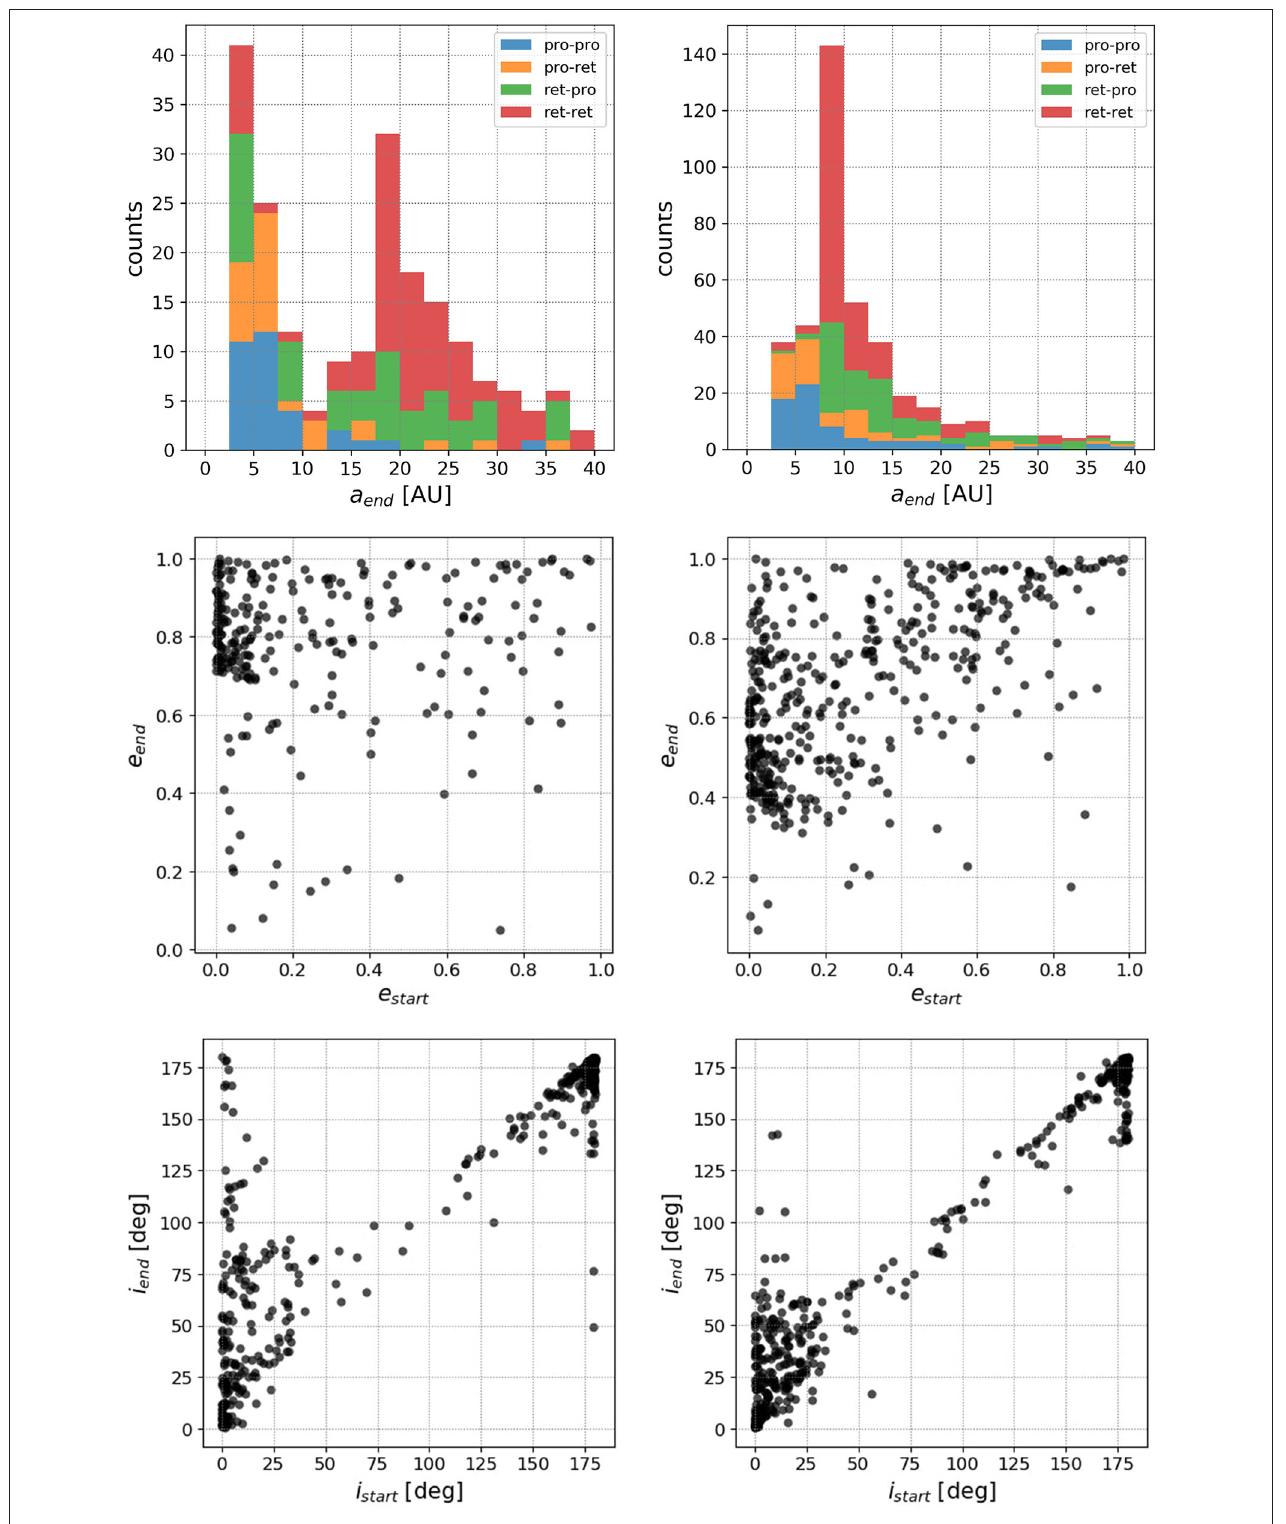
FIGURE 2 | Left column: Ganymede, right column: Callisto. The top row shows the semi-major axes at closest approach. The middle row shows the initial eccentricity of the last generation vs. the eccentricity at the measurement. The bottom row shows the respective inclinations. Each datapoint corresponds to an independent